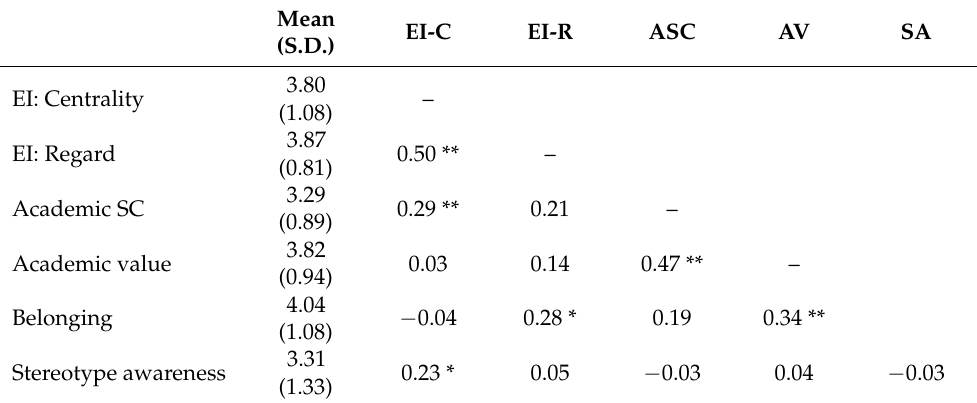
Table 2. Means, standard deviations, and correlations for ethnic identity and academic motiva- tion variables. Mean